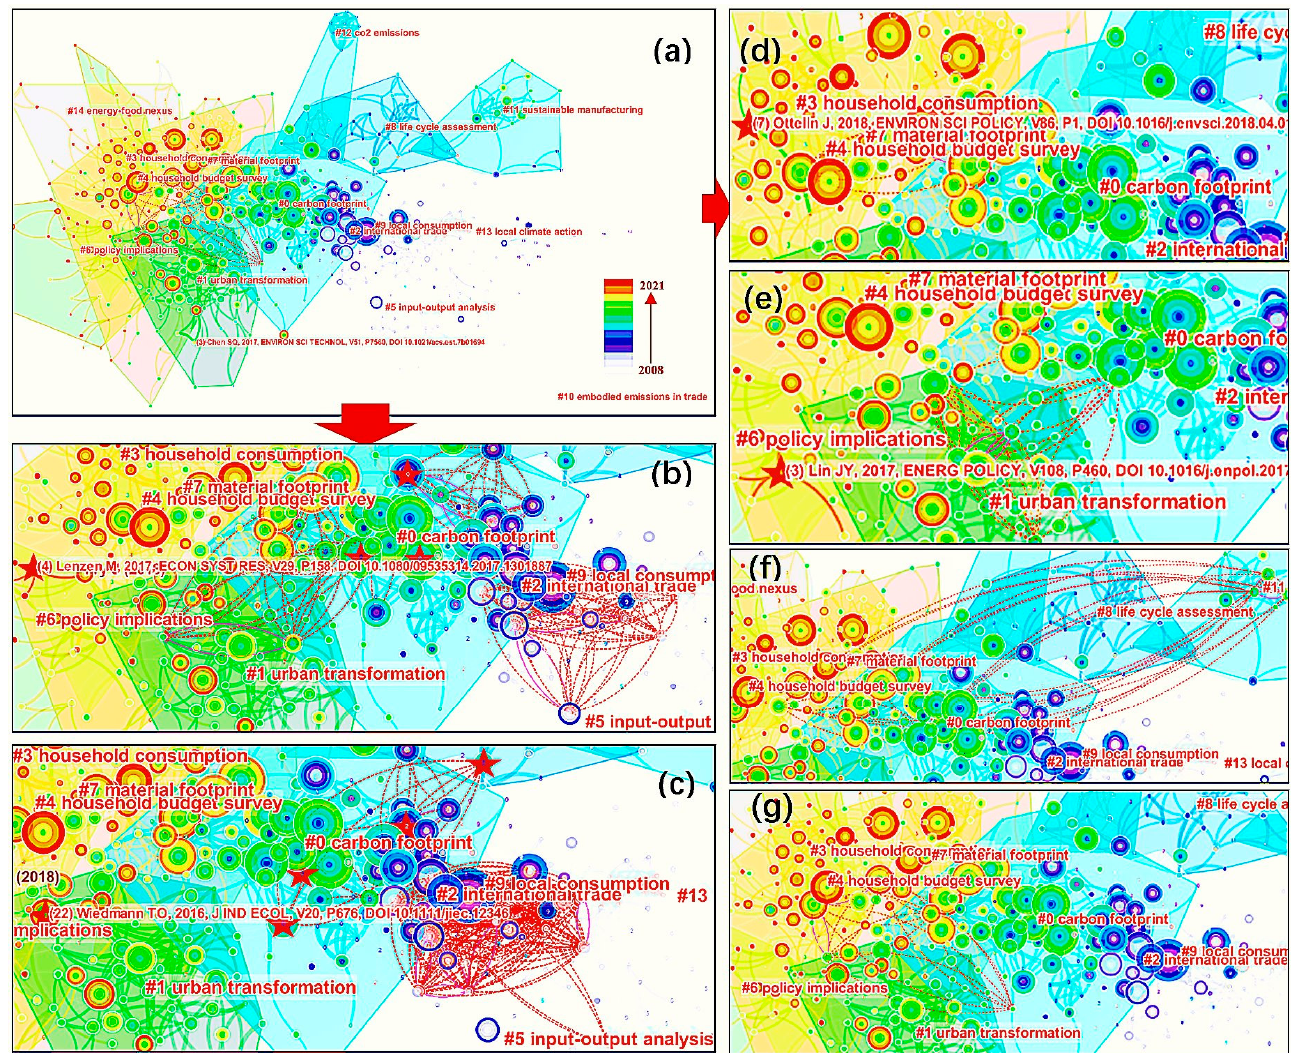
Figure 8. Whole clusters of cited articles. ( a ); Novel co-citations of 6 papers by Lenzen ( b ) and 7 papers by Wiedmann ( c ). Novel co-citations of papers by Ottelin ( d ), Lin ( e ), Kucukvar ( f ), and Hamilton ( g ).